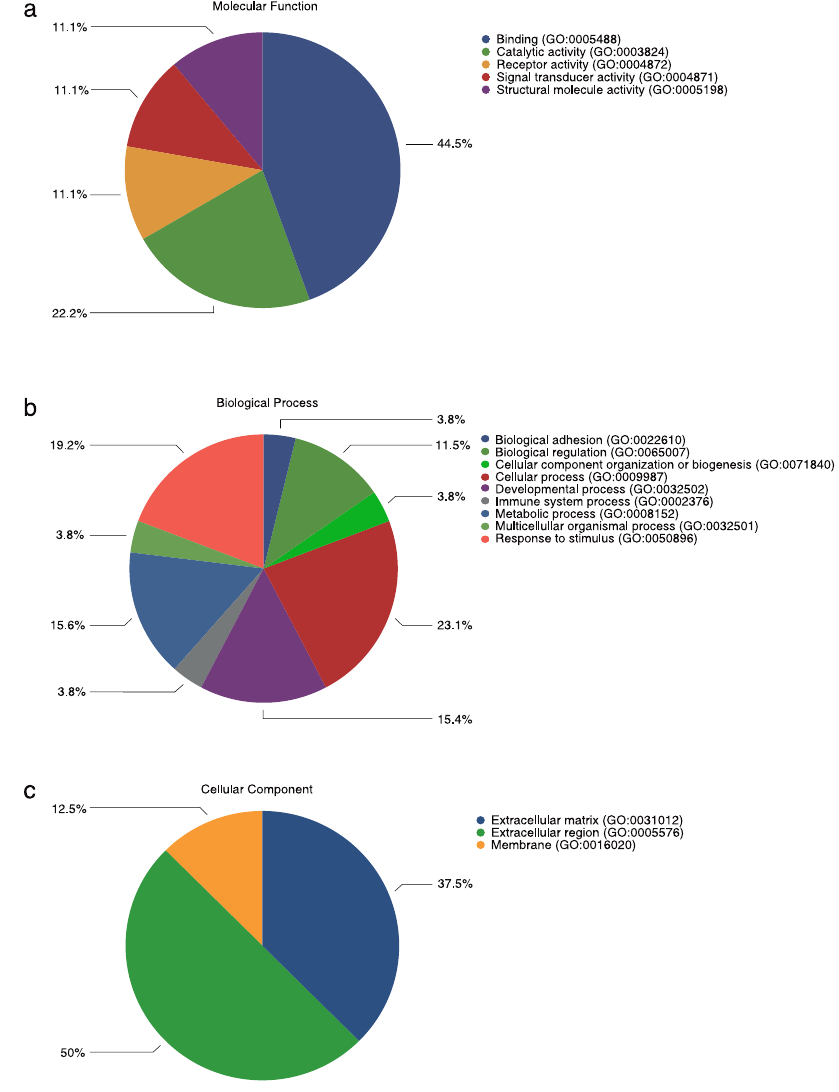
Figure 4. Acid bone lysate (ABL) provokes changes in gene expression based on gene arrays. Eighteen genes were at least 10-fold up- and down-regulated by ABL (Table 2). Panther analysis of molecular